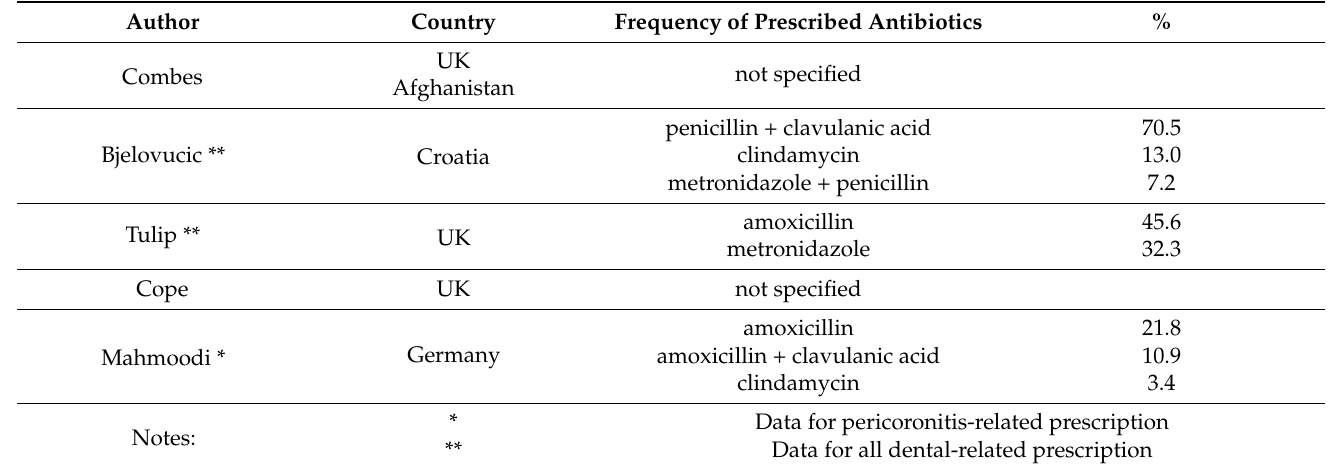
Table 12. Frequency of prescribed